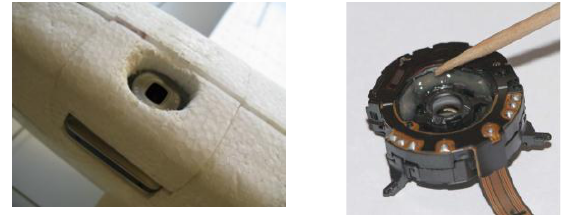
Figure 2: Used consumer camera mounted on UAV belly (left) and fixed lens element